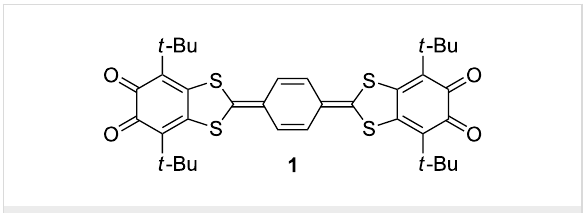
(Figure 2a) is a triplet (1:2:1) of triplets (1:2:1) of doublets and it was attributed to the protonated semiquinonate radical